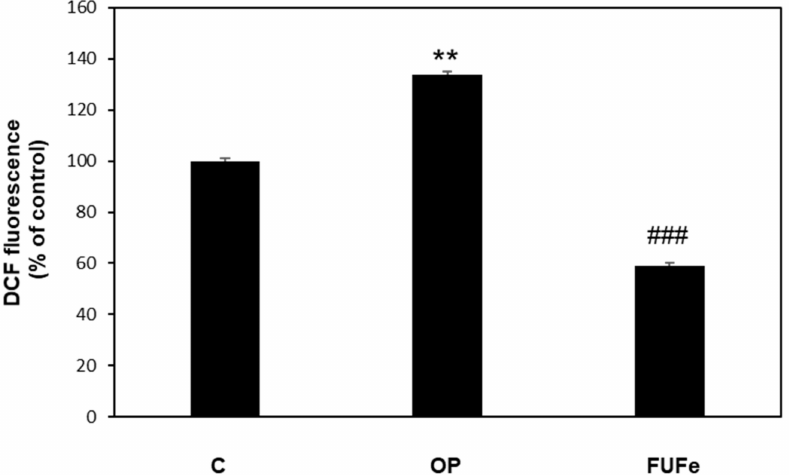
Figure 1. Effects of FUFe on ROS production in steatotic FaO cells DCF fluorescence was quantified in control (C) and steatotic cells incubated in the absence (OP) or in the presence of 50 µ g/mL FUFe for 24 h. Data are expressed as percentage of control. Values are mean ± S.D. from three independent experiments. Significant differences are denoted by symbols: ** p ≤ 0.01 vs. control; ### p ≤ 0.001 vs.